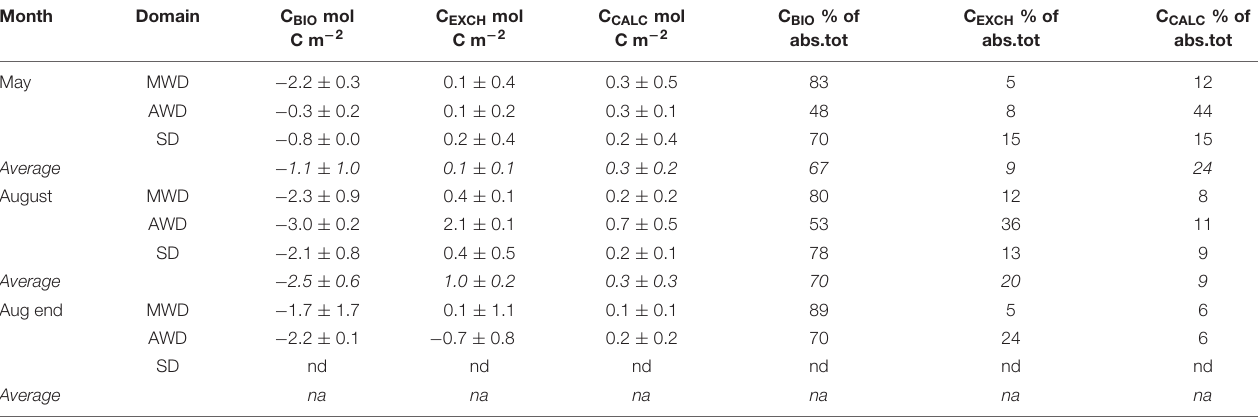
TABLE 1 | Summary and direction of the estimated drivers of the mean and standard deviation for the seasonal DIC change (C DIC , mol C m − 2 ) integrated in the top 50 meters in the three study domains: meltwater influenced domain, MWD, Atlantic water domain, AWD, and the shelf domain, SD, in May, August, and end of August 2014.